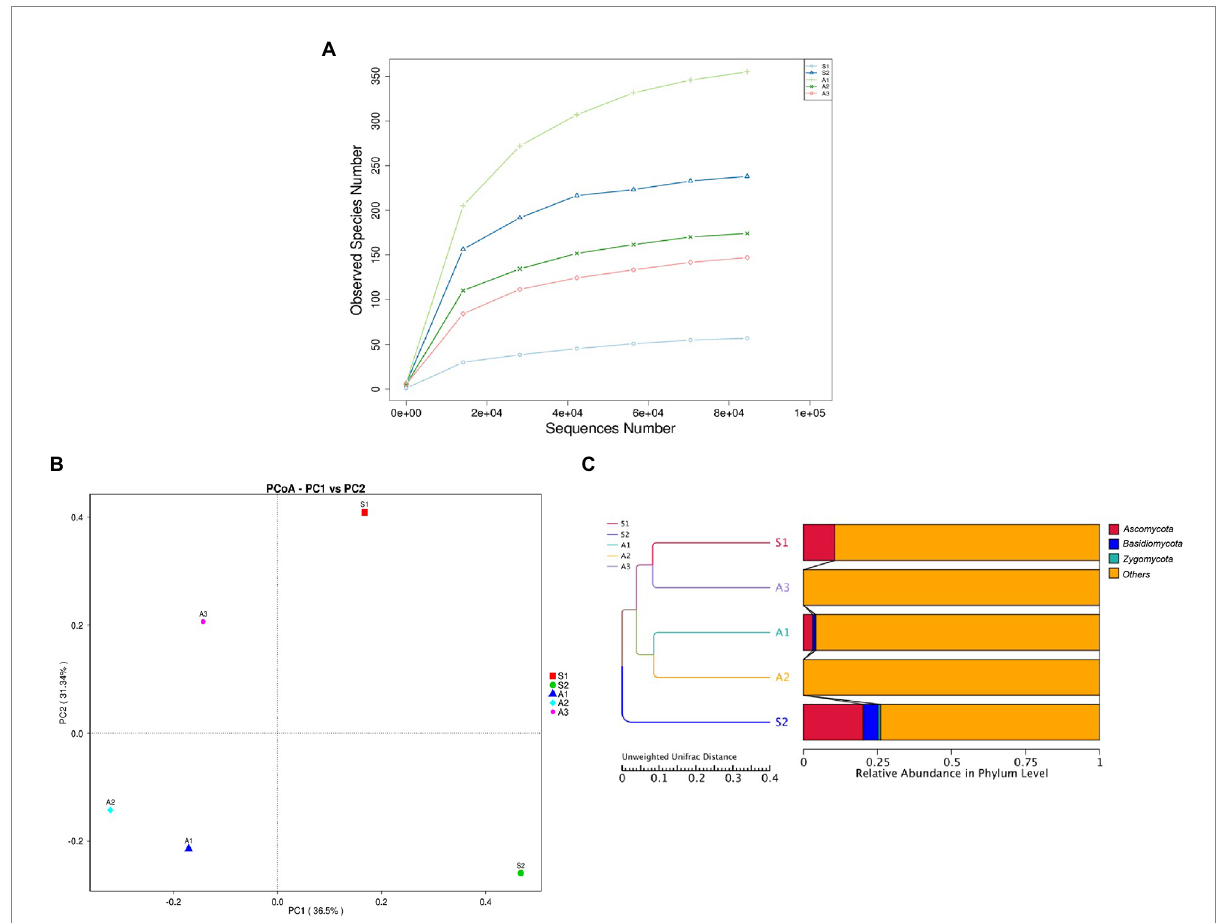
FIGURE 4 Alpha diversity and beta diversity analysis. (A) Rarefaction curve of fungal OTUs in sponges and algae (B) Principal co-ordinate analysis (PCoA) analysis of relative fungal abundance. (C) UPGMA cluster tree based on Unweighted Unifrac